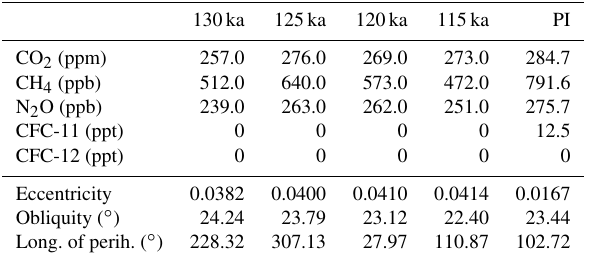
Table 3. Greenhouse gas concentrations and orbital parameters used for the NorESM and MAR climate simulations (PI: pre-